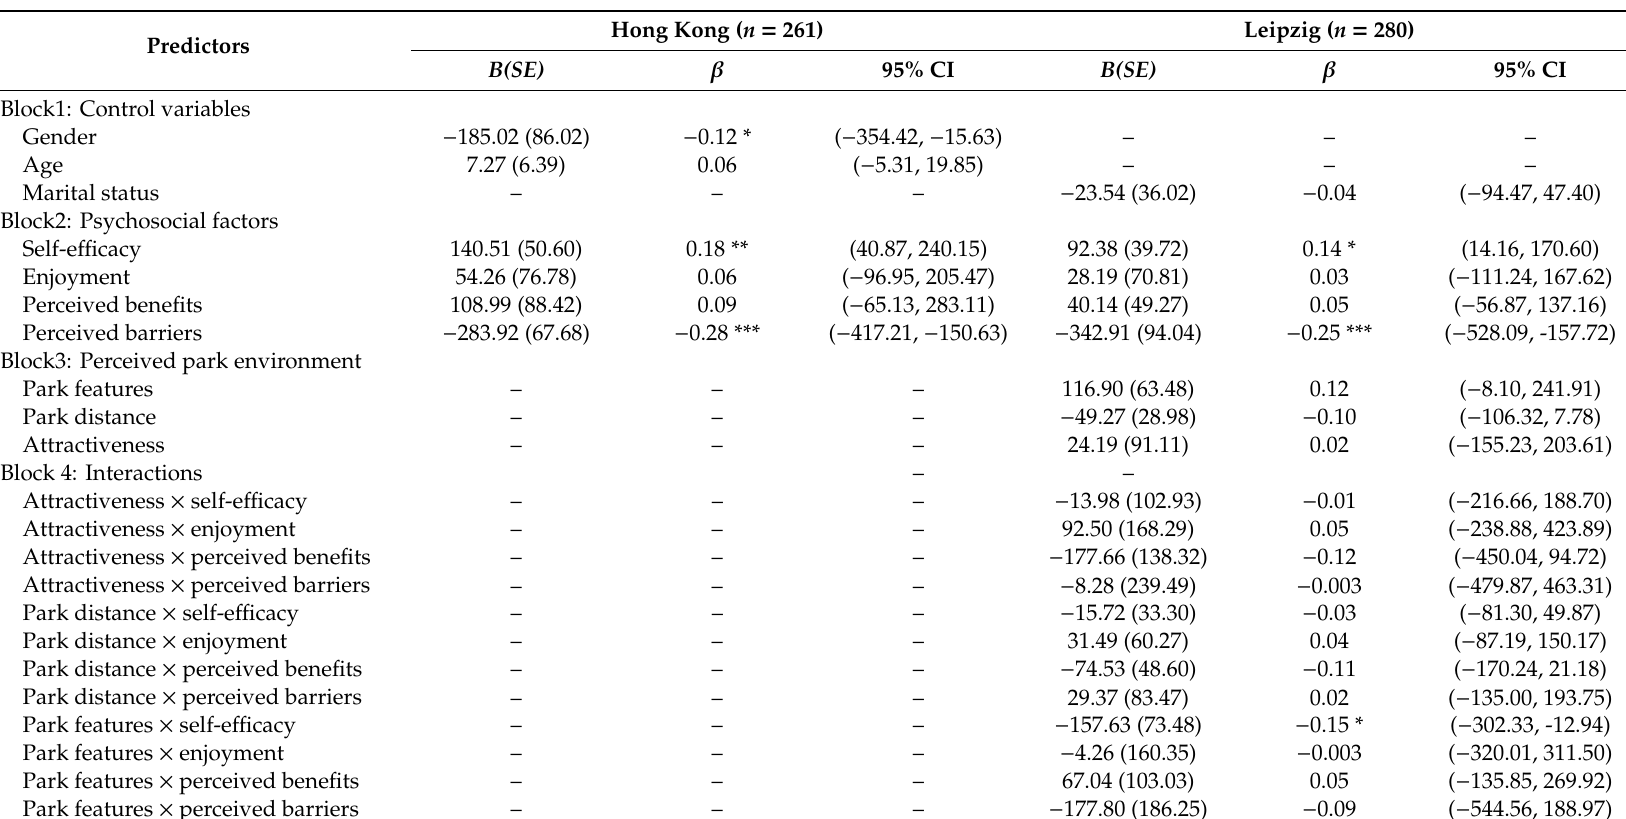
Table 4. Results of the hierarchical multiple regression analysis predicting the perceived park environment, psychosocial factors and their interactions in the associations with park-based PA among older adults from Hong Kong and